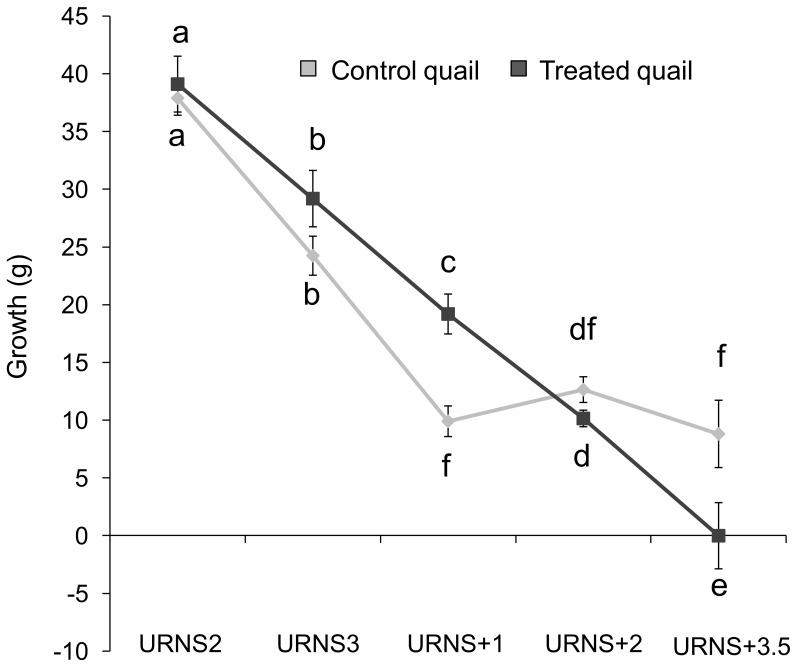
Body weight gain between weeks (mean in mm ± SEM).URNSX: increase between X-1 and X week(s) after the end of the URNS procedure. Control quail: N = 19, treated quail: N = 22. Post-hoc Tukey HSD tests: different letters means significant differences.